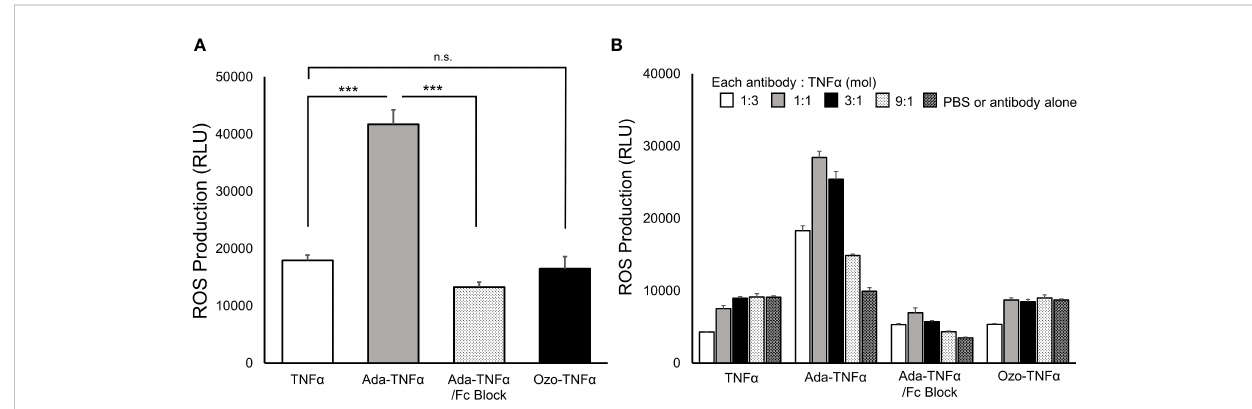
FIGURE 3 Production of ROS in mouse neutrophils activated by anti-TNF a antibody-TNF a ICs. Representative chemiluminescence values of extracellular MPO-dependent ROS as measured by the L-012 chemiluminescence assays are shown. ROS production by neutrophils (5 × 10 5 cells/well in CL medium) after incubation for 1 min at 37°C with uncomplexed TNF a , adalimumab-TNF a ICs (Ada-TNF a ), adalimumab-TNF a ICs with MOUSE SEROBLOCK FcR (Ada-TNF a /Fc Blocker), and ozoralizumab-TNF a ICs (Ozo-TNF a ) was monitored. Equimolar amounts of anti-TNF a antibodies and